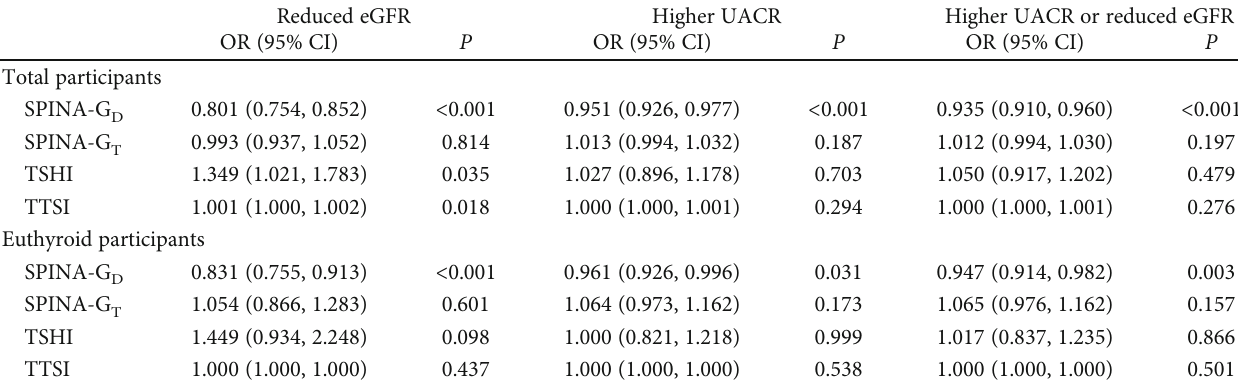
Table 4: Associations of thyroid homeostasis parameters with kidney